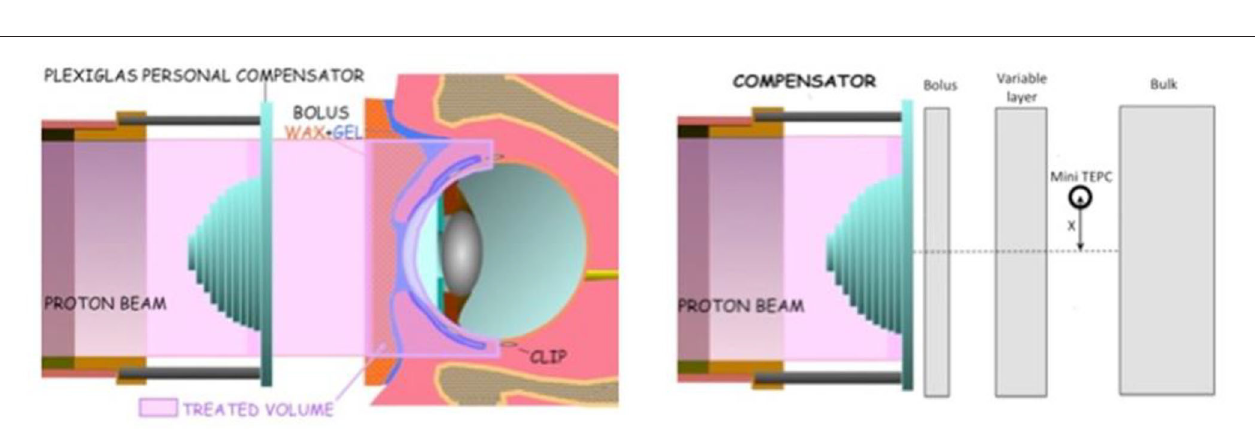
FIGURE 9 | (Left) : Sketch of the irradiation setup of the conjunctival melanoma treatment. The compensator is a polymethyl methacrylate (PMMA) phantom, which is designed to shape the spread-out Bragg peak (SOBP) as the conjunctive. (Right) : Sketch of the irradiation setup used for microdosimetric measurements, where the gray rectangles are PMMA layers, which substitute bolus and patient eye. The mini-tissue-equivalent proportional counter (TEPC) distance from the beam axis (X) has 0.1mm of precision. Data from De Nardo et al. [30].